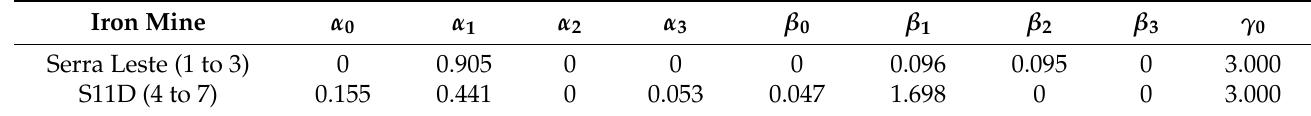
Figure 6. Measured and predicted PSD curves in Scenario 1 for the S11D datasets. ( a ) PSD predicted using the model calibrated on datasets 4 to 7. Dataset 4 is used for validation. ( b ) PSD predicted using the model calibrated on datasets 4 to 7. Dataset 5 is used for validation. ( c ) PSD predicted using the model calibrated on datasets 4 to 7. Dataset 6 is used for validation. ( d ) PSD predicted using the model calibrated on datasets 4 to 7. Dataset 7 is used for validation. Table 4. Calibrated parameters in Scenario 1.